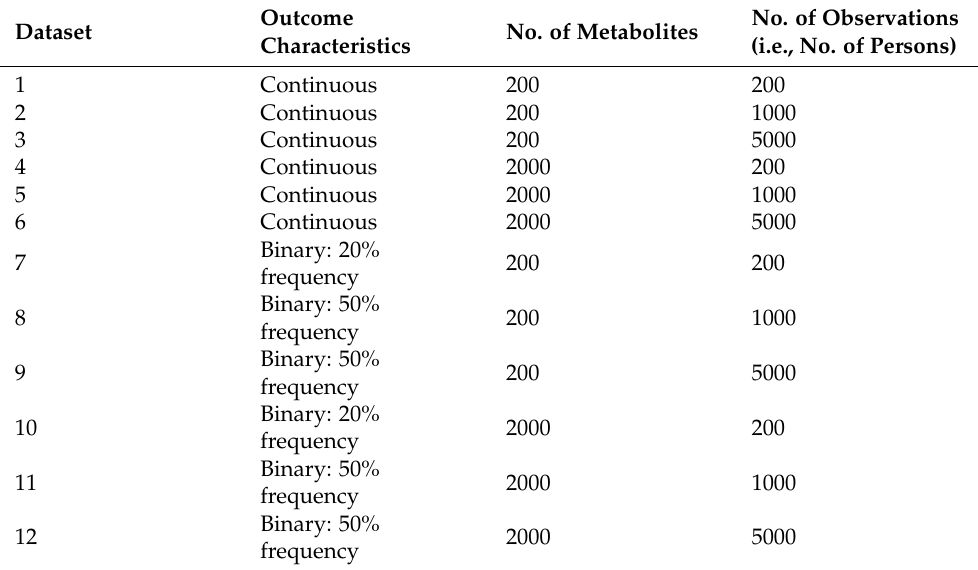
Table 1. Data structures used for